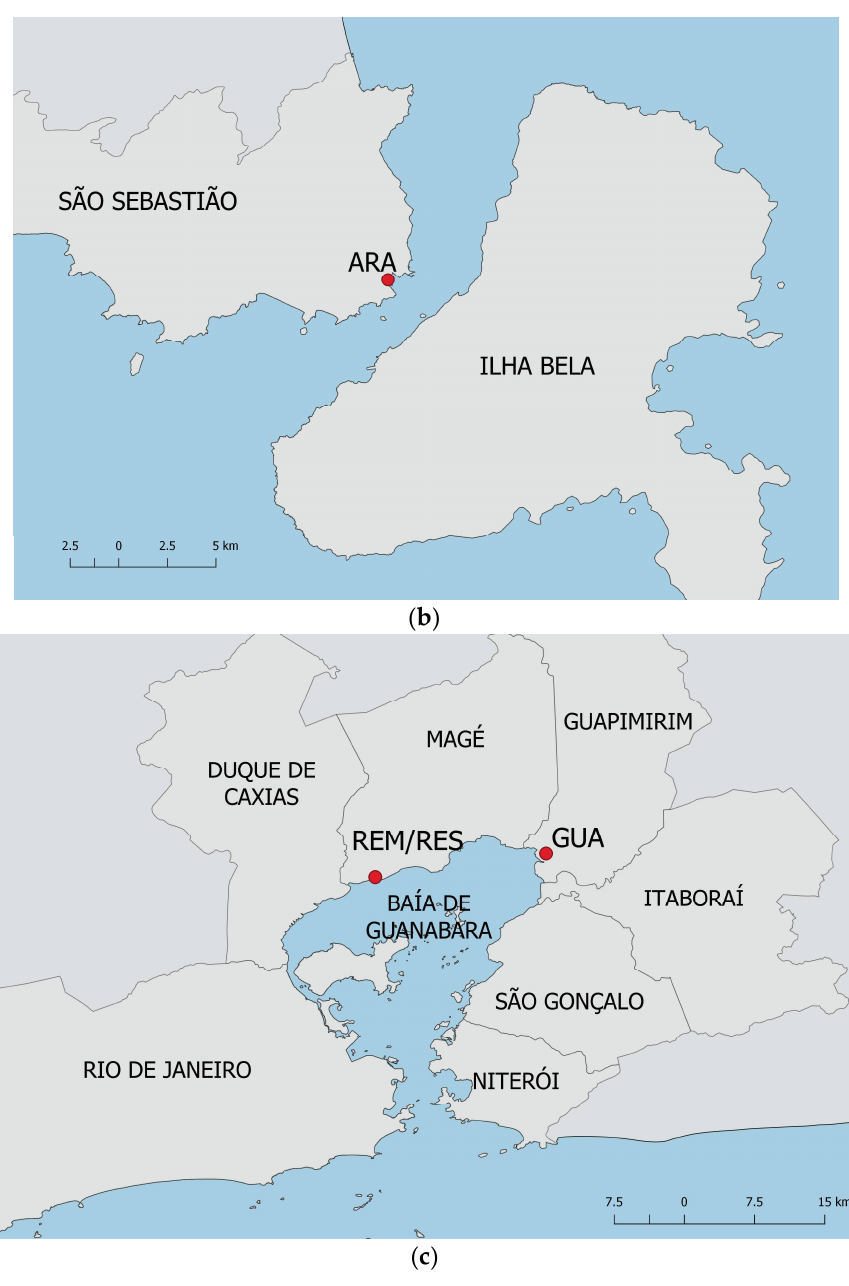
Figure 1. ( a ) Location of the studied areas in the states of Rio de Janeiro (RJ) and São Paulo (SP) within Brazil; ( b ) map showing Araçá Bay area. The red circle represents the collection site ARA; ( c ) map showing Guanabara Bay in detail. The location of the restored site in Mauá Beach (Restored (RES) and Remnant (REM)) is represented by a red circle on the left. The conserved mangrove in the Ecological Station (ESEC) Guanabara (GUA) is represented by a red circle on the right.